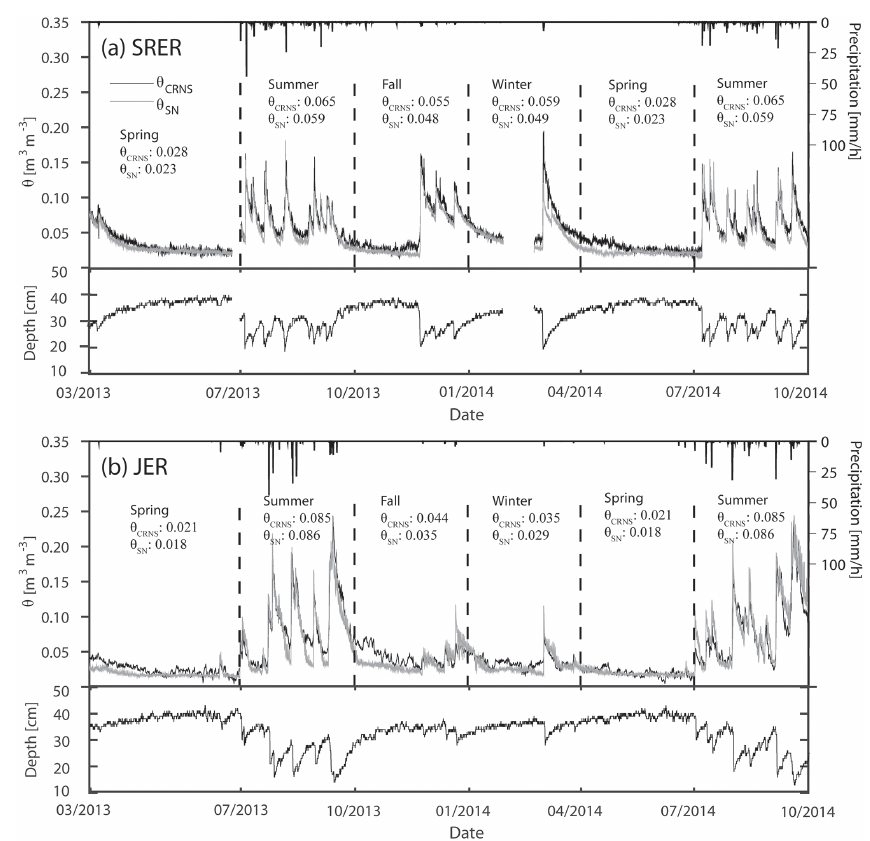
Figure 4. Comparison of the spatially averaged, hourly soil moisture (m 3 m − 3 ) from CRNS method ( θ CRNS , black lines) and distributed sensor network ( θ SN , gray lines) at (a) SRER and (b) JER, along with spatially averaged, hourly precipitation during 1 March 2013 to 30 September 2014. Vertical dashed lines indicate the seasonal definitions and their corresponding seasonally averaged θ CRNS and θ SN inm 3 m − 3 . Also shown are the time-varying measurement depths ( z ∗